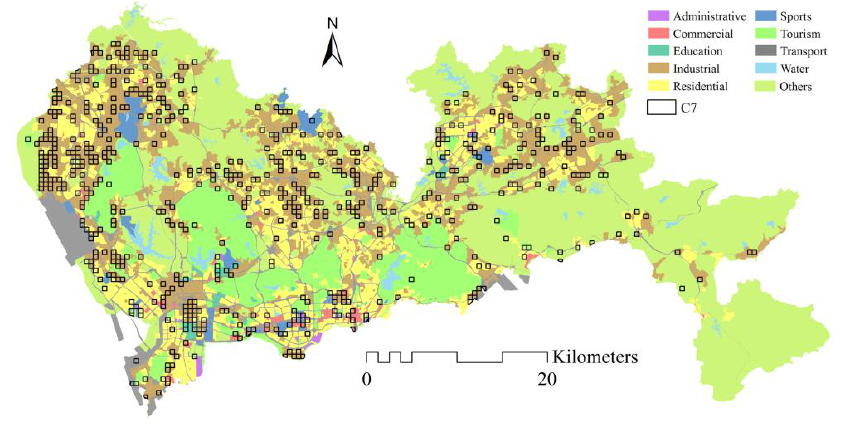
Figure 10. Spatial distribution of identified functional cluster C 7.